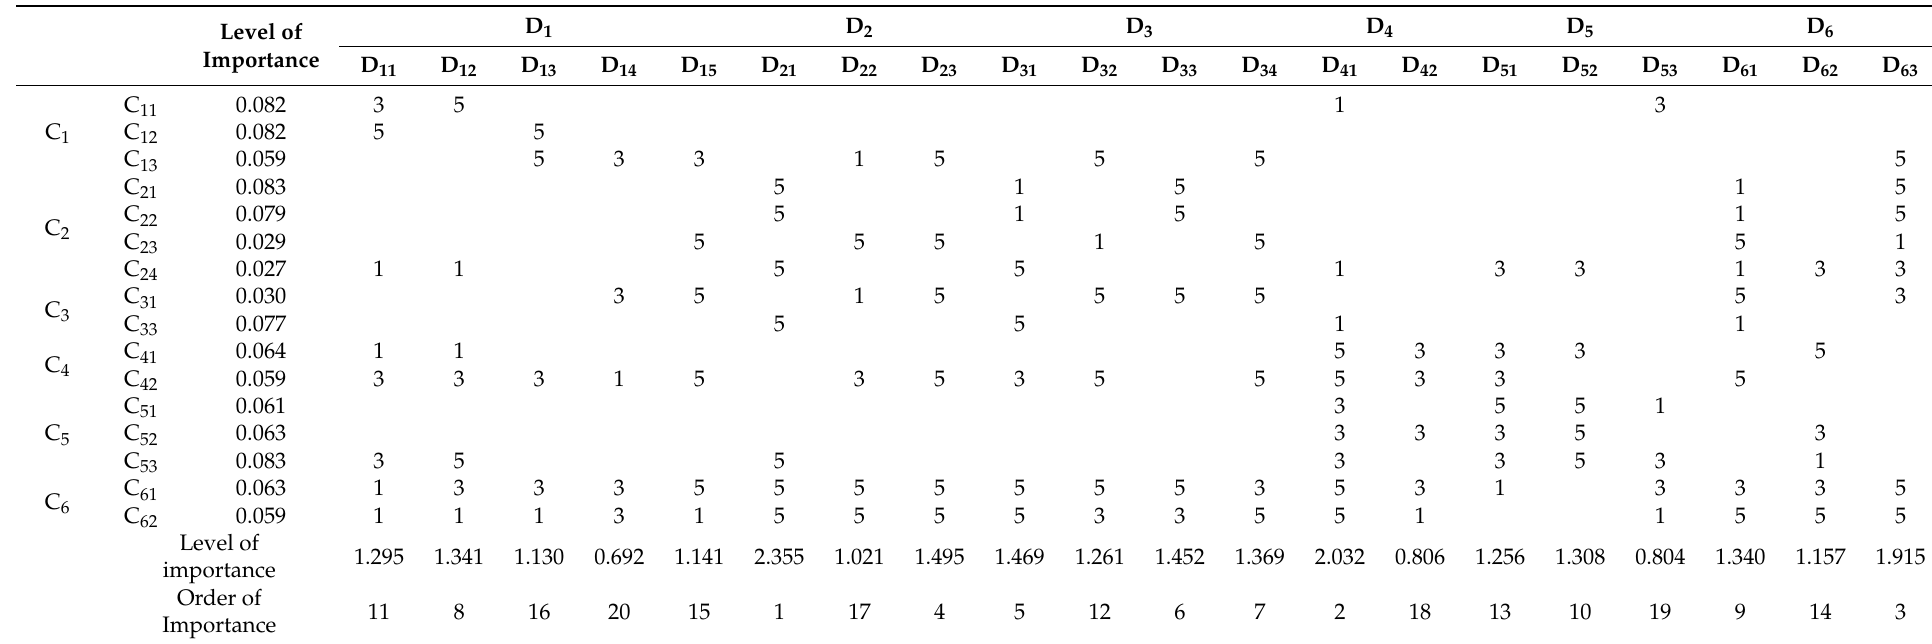
Table 4. User requirements and design requirements house of